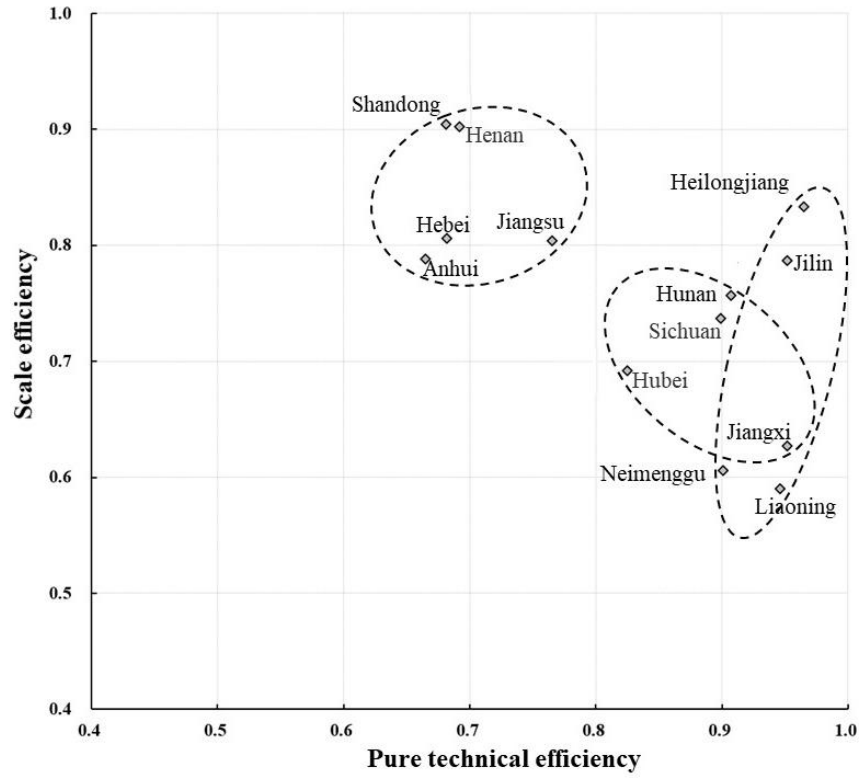
Figure 6. Scatter diagram of pure technical efficiency and scale efficiency after adjustment. Table 5. Regional grain production resource allocation efficiency during five-year planning